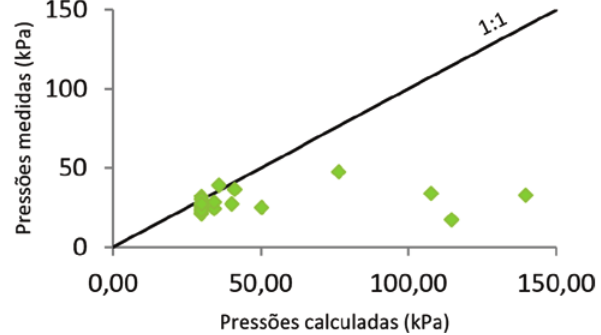
Figura 3 Pressões calculadas com ACI 347 R-04 versus pressões medidas para velocidades de concretagem entre 0,45 e 6,38 m/h Fonte : elaborada pelos